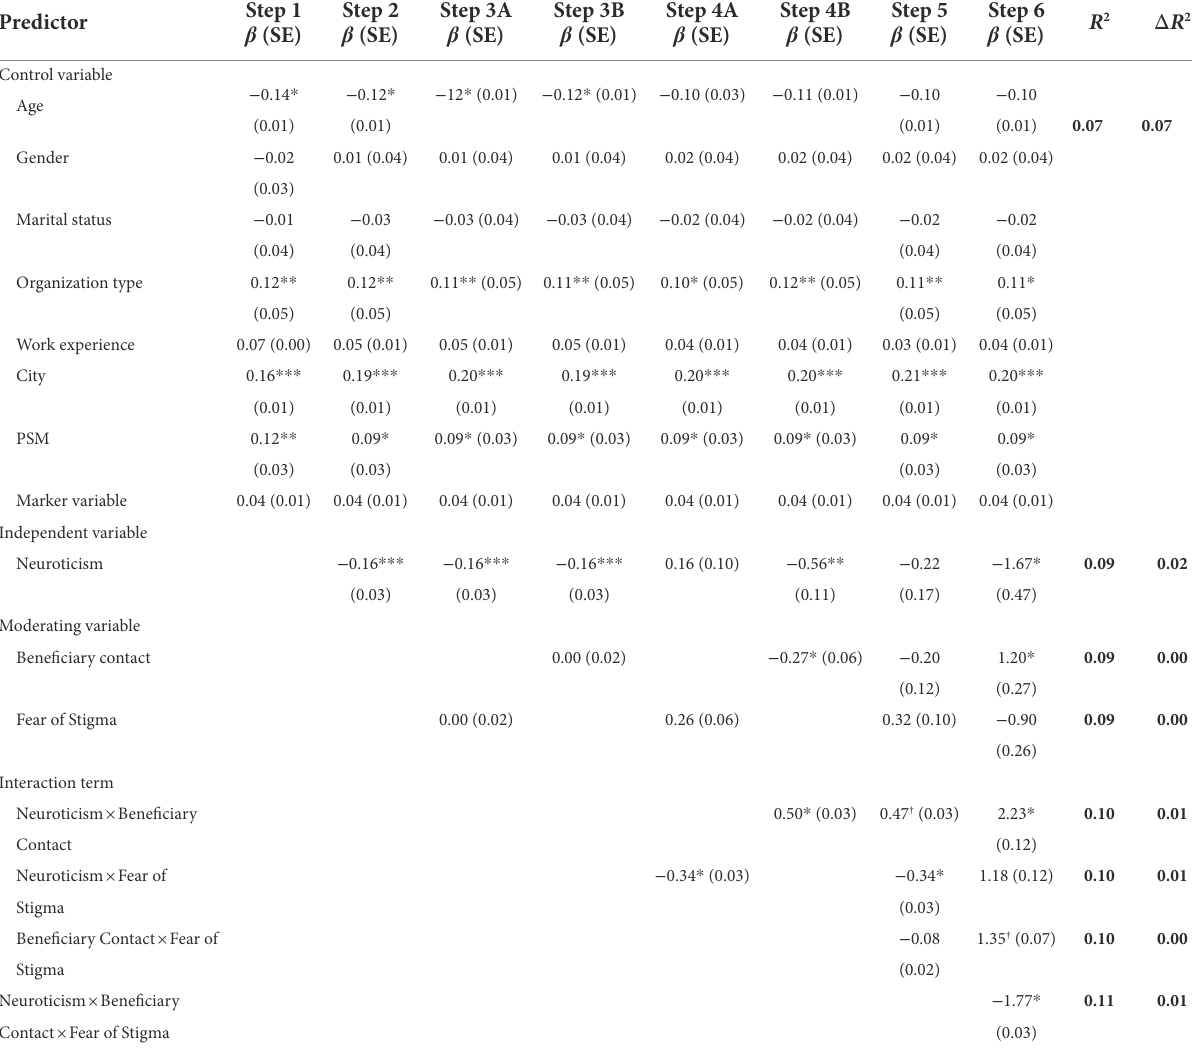
TABLE 2 Moderation effect of fear of stigma and beneficiary contact on neuroticism-work engagement relationship.